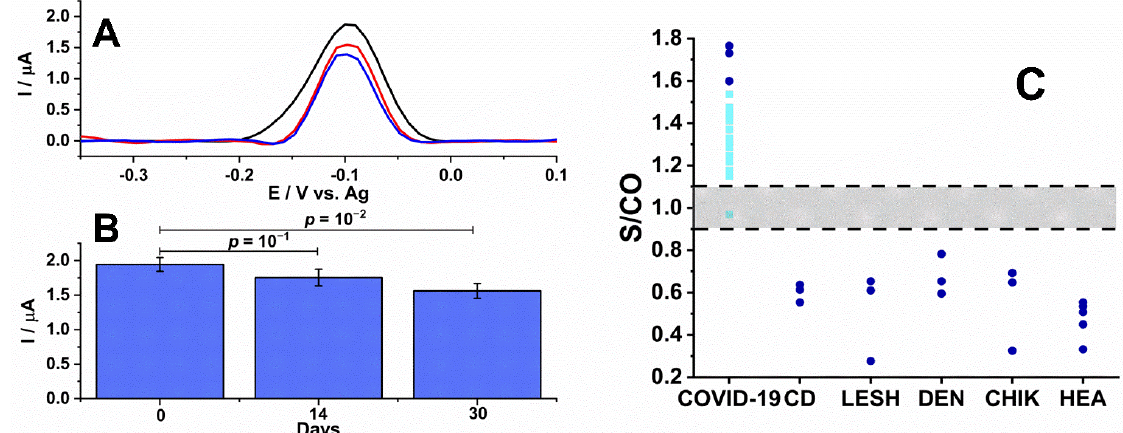
Figure 4. Stability, performance, and cross-reactivity of EP2 conjugated SPEs. ( A ) SPE reproducibility was evaluated by fabricating multiple SPEs according to the optimized protocol and performing SWVs in positive serum (1:100) on the day of fabrication (black line, n = 3), after 14 days of storage at 4 °C (red line, n = 3) and 30 days of storage at 4 °C (blue line, n = 3). ( B ) The graph shows the variations in recordings. ( C ) For real-world applications, the cut-off was determined using positive and negative controls (dark blue). Multiple serum samples from persons suspected of having COVID-19 (light blue); individuals with Chagas disease (CD; Trypanosoma cruzi ), leishmaniosis (LESH), dengue (DEN), and chikungunya (CHIK); and healthy (HEA) patients were assayed. The gray region represents ±10% .